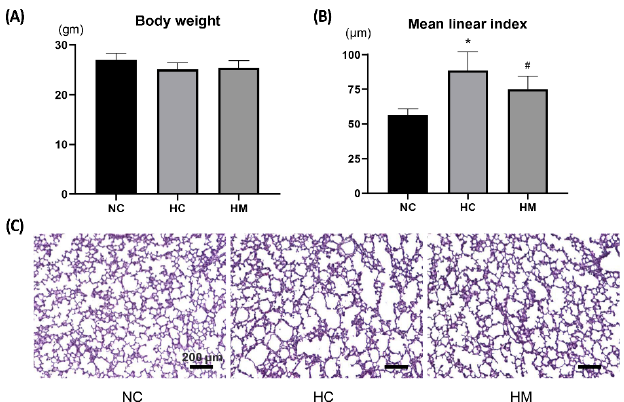
Figure 1. The body weight and degree of alveolarization of P14 rat lungs exposed to prolonged hyperoxia in vivo. Body weight ( A ) and degrees of alveolarization were assessed by the mean linear intercept of the lung sections ( B ) of P14 rats. ( C ) Representative optical microscopy photomicrographs of lung sections stained with hematoxylin and eosin (scale bar = 200 µ m). Data are presented as the mean ± standard deviation. Abbreviations: NC, normoxia control; HC, hyperoxia control; HM, hyperoxia with transplantation of human UCB-MSCs. *, p < 0.05 compared with the NC group; #, p < 0.05 compared with the HC